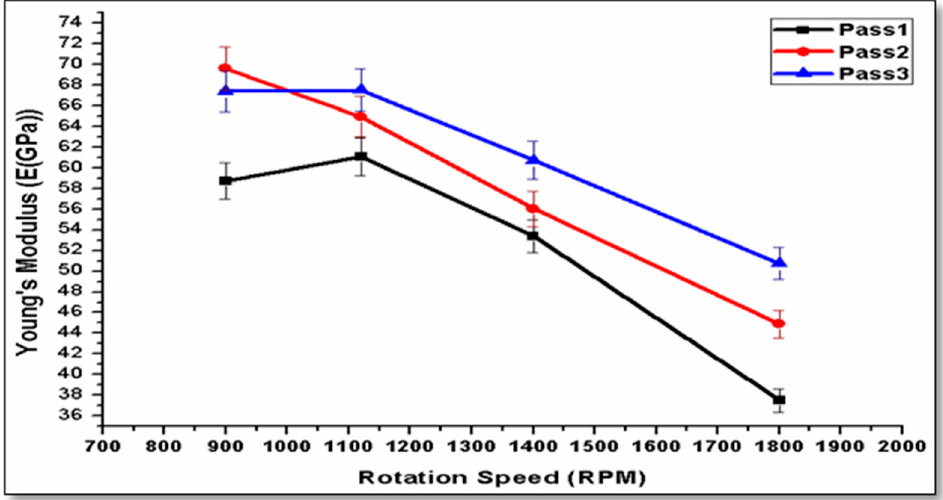
Figure 8. Effect of tool speed on the young’s modulus at 15 mm/min over three passes.